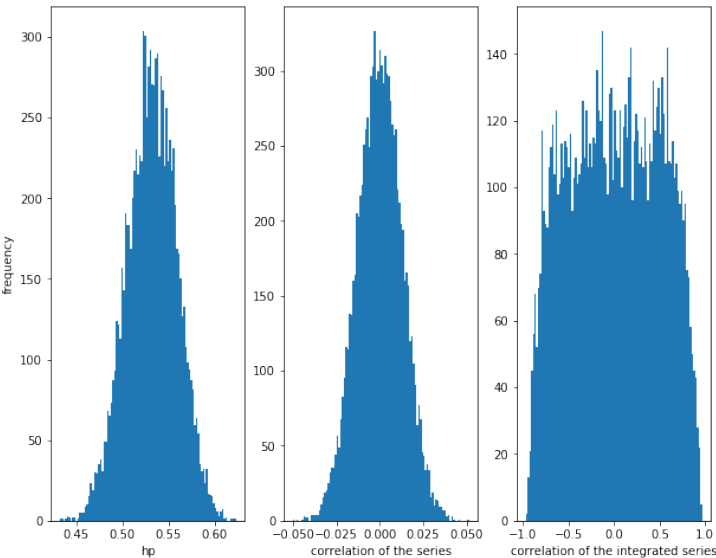
Figure 11. Histogram of the relationships in series with a Student’s t copula relationship with ρ = 0 and ν = 3. With a null correlation, HP is close to 0.5 and the correlation close to 0, while the dispersion of the correlation of the integrated series is